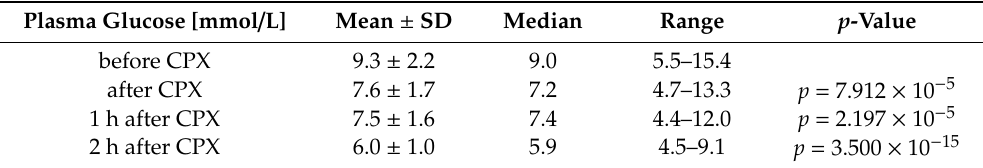
Figure 1. Plasma glucose during aerobic exercise (CPX). Plasma glucose (PG) is displayed in mmol / L as individual values for every patient ( n = 50), measured before and immediately after 30 min of aerobic exercise (CPX) as well as 1 and 2 h after CPX. Statistical analysis is performed in comparison with PG before CPX. Table 3. Plasma glucose before and after aerobic exercise (CPX).